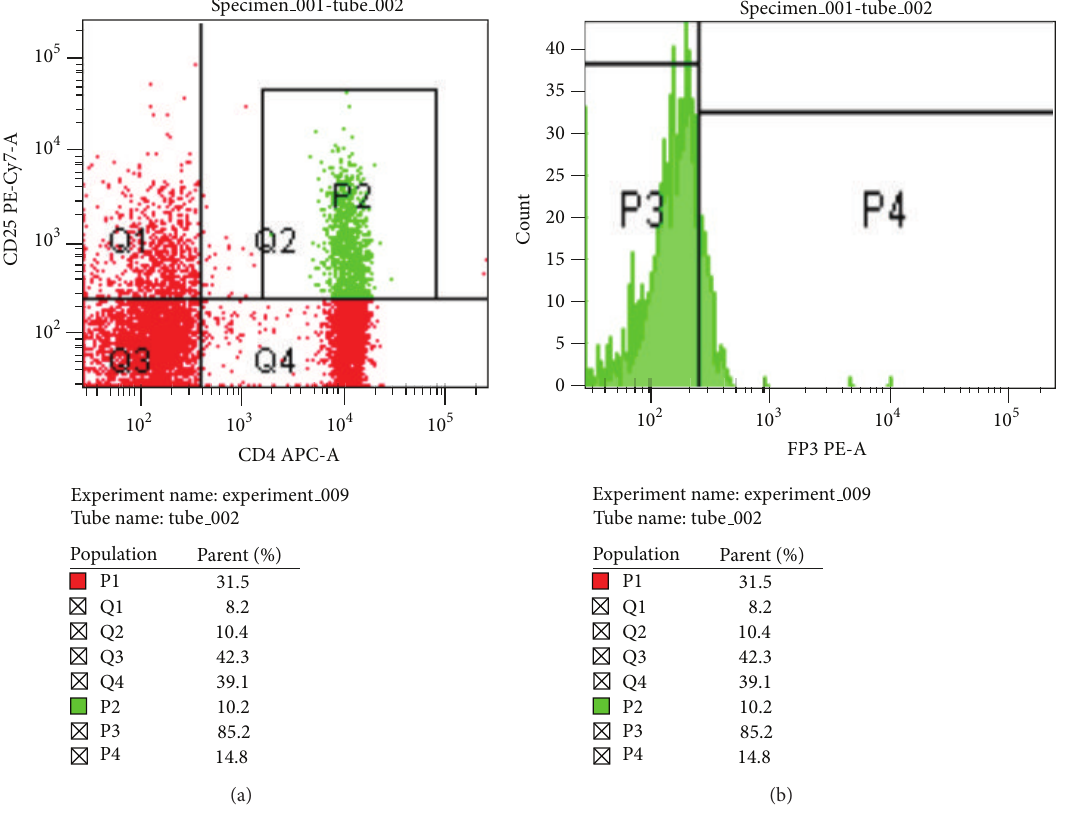
Figure 4: The expression level of CD4 + CD25 + and FOXP3 was examined by flow cytometry in asthmatic group. (a) Representation plots of CD4 + CD25 + cells (b) and FOXP3 expression in study group.